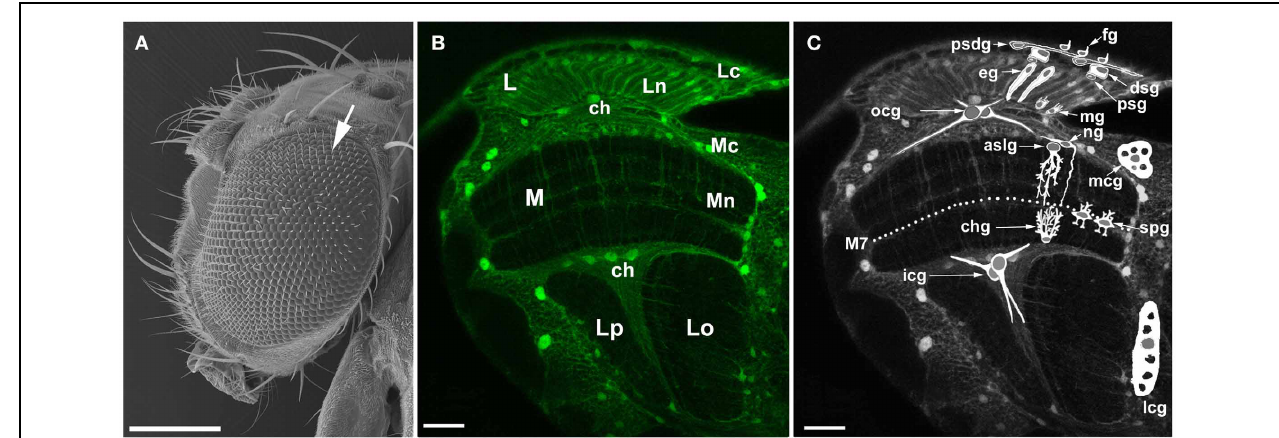
FIGURE 1 | The visual system of the fruit fly, Drosophila melanogaster . (A) Scanning electron micrograph of a head and a large compound eye. The eye is composed of approximately 800 hexagonal units called facets or ommatidia (arrow). The ommatidial array of photoreceptors in the retina receives photic and visual information, transduces it into receptor action potentials and transmits to underlying optic lobe. Scale bar: 200 μ m. (B) Confocal image of the optic lobe of transgenic flies Repo-Gal4 × UAS-S65T-GFP, in horizontal section. Targeted expression of Green Fluorescence Protein (GFP) to glial cells reveals the general morphology of the optic lobe. There are three synaptic regions (neuropils) beneath the retina of the compound eye: the lamina (L), the medulla (M), and the lobula that in Diptera consists of the lobula (Lo) and the lobula plate (Lp).